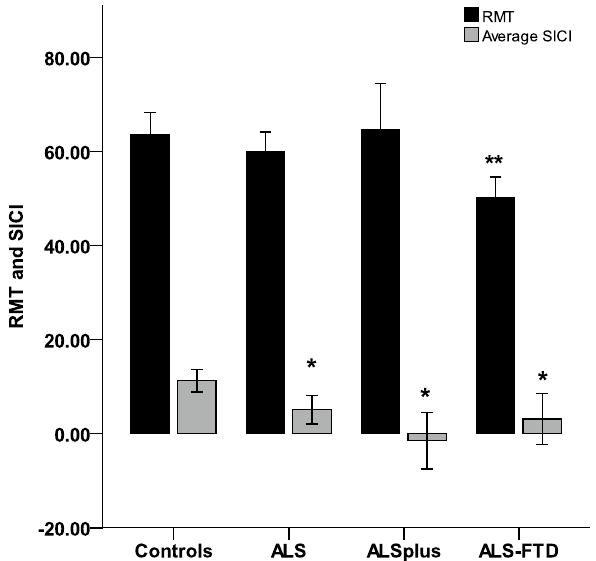
Figure 1. Cortical excitability in ALS. SICI was significantly low in ALS, ALS-Cog and ALS-FTD compared with controls. RMT was low only in ALS-FTD compared with controls. *p < 0.05 compared to controls for all three groups, **p < 0.05 for ALS-FTD compared to